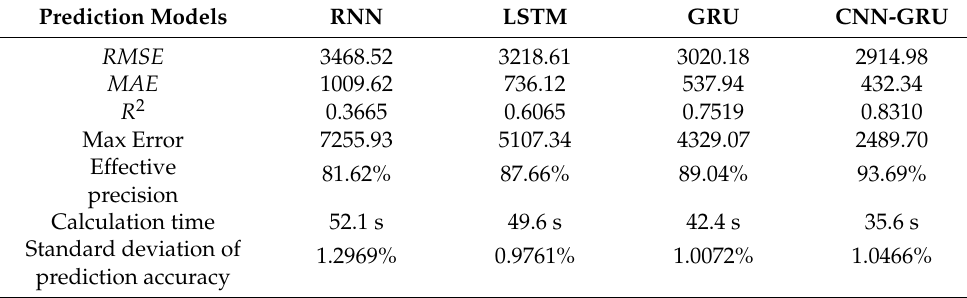
Table 5. Model evaluation index before feature selection.